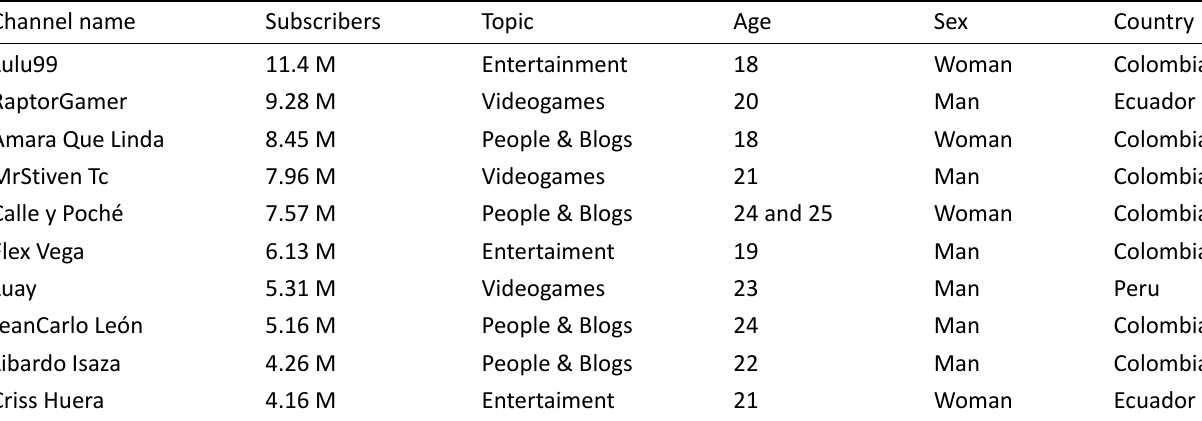
Table 1. Top 10 young YouTubers of the Andean Community.